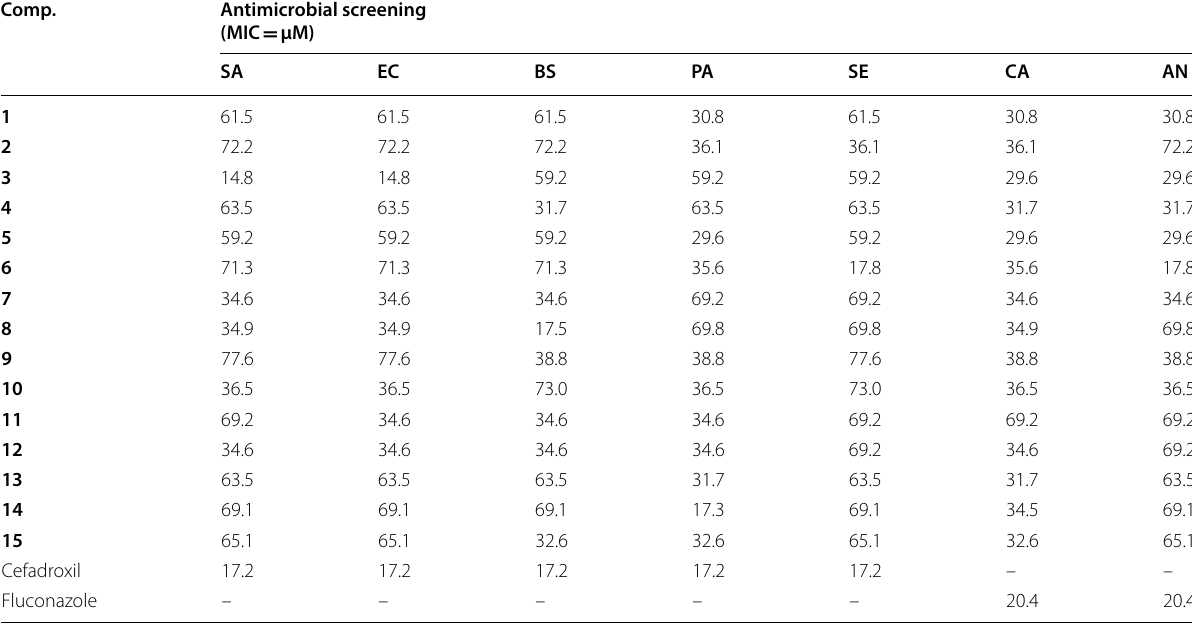
SA, Staphylococcus aureus, EC, Escherichia coli; BS, Bacillus subtilis; PA, Pseudomonas aeruginosa; SE, Salmonella enterica; CA, Candida albicans; AN, Aspergillus niger